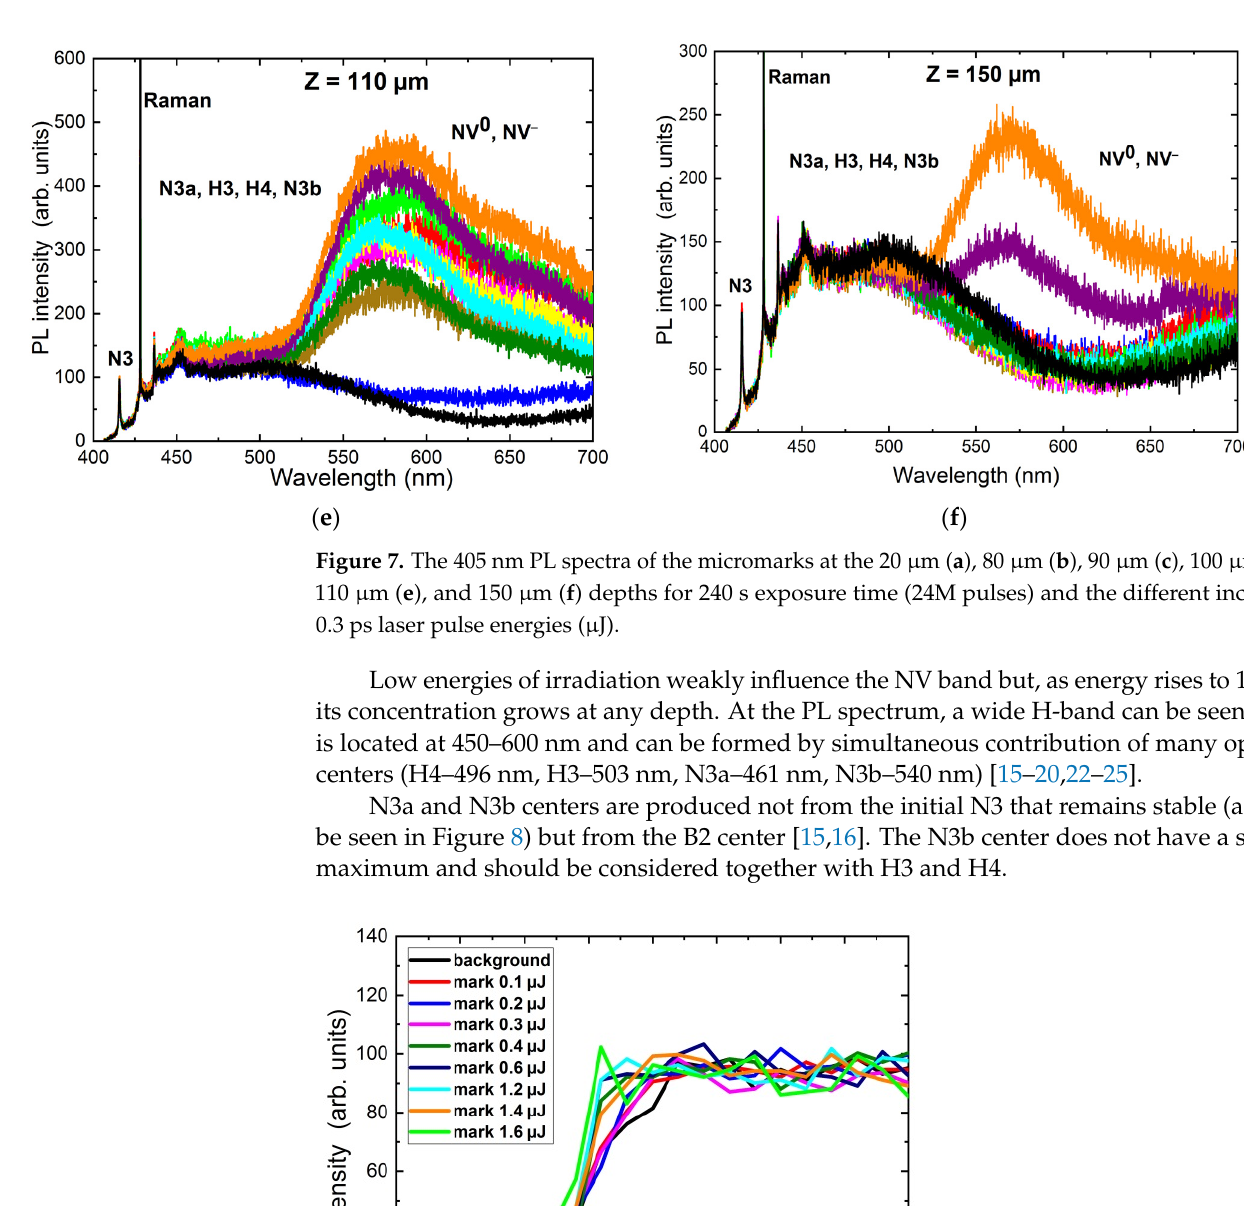
Figure 8. Dependence on depth z (µm) for different incident pulse energies at N3 ~ 415 nm center. At higher energies, two bands—one-for the H-band (max at 550 nm) and the second for the NV band (max at 660 nm)—are joined into the common one located near the focal plane (Figure 7b–e).